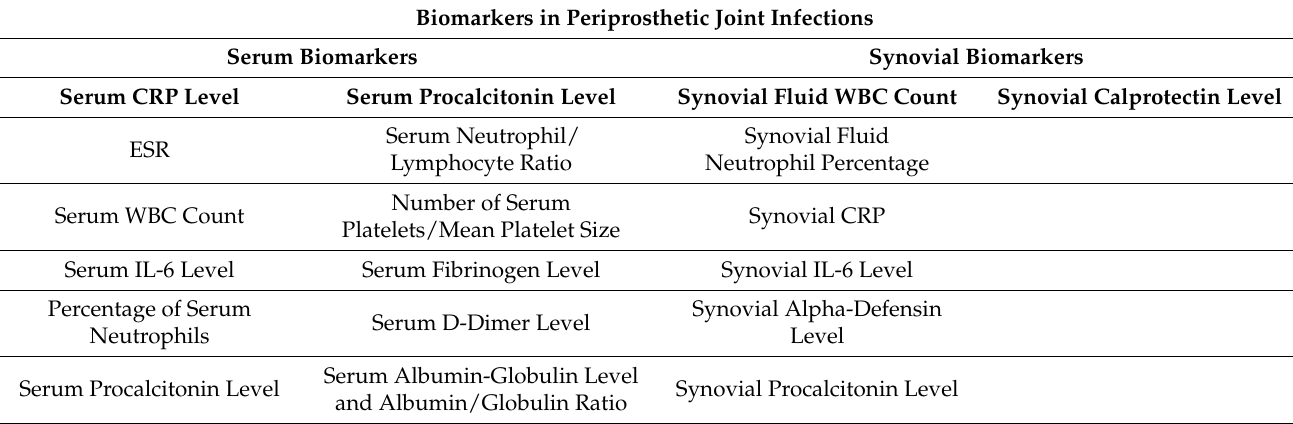
Table 1. Serum and Synovial Biomarkers in Periprosthetic Joint